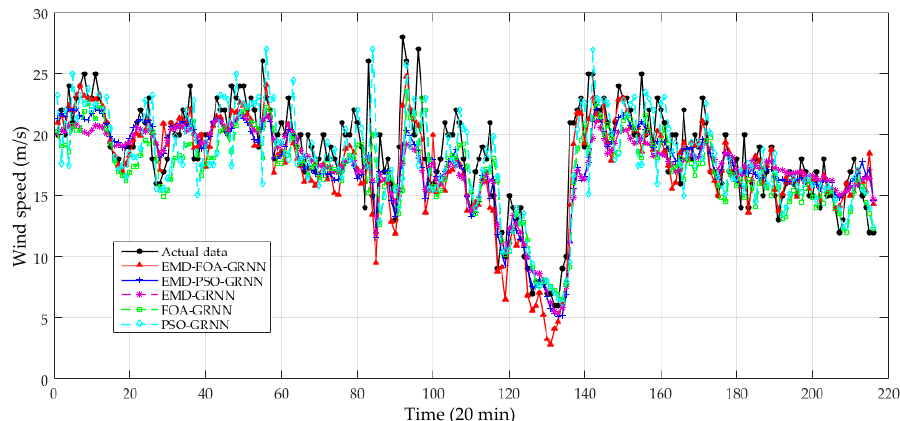
Figure 13. The geographical location of Xilinguolemeng City.